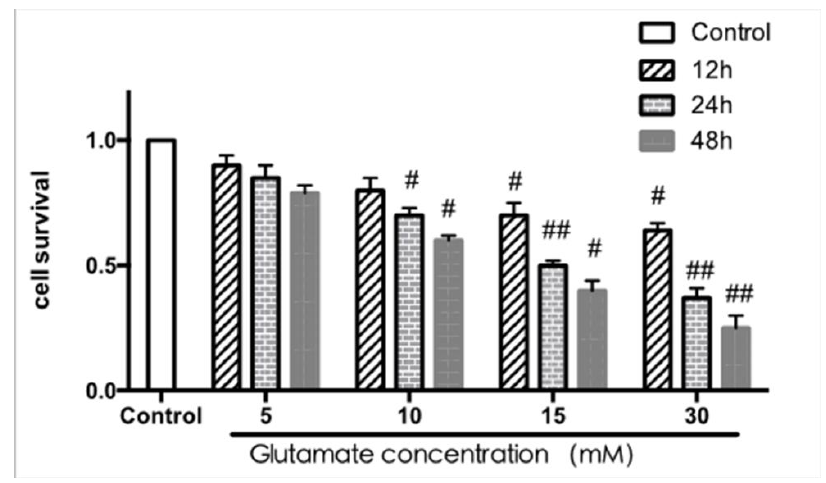
__ ± s , n = 4). # p < 0.05 ## p < 0.01